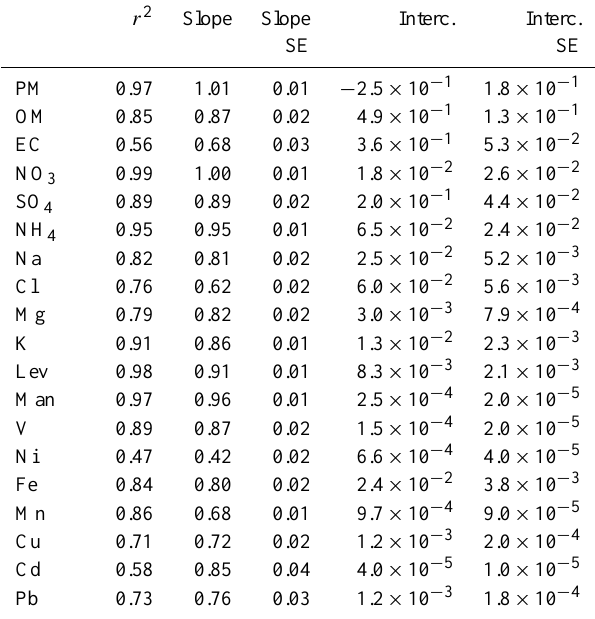
Table 1. Statistics describing measured versus modelled concentra- tions for each chemical species and for PM 2 . 5 mass. Interc.: inter- cept (µgm − 3 ), SE: standard error. r 2 Slope Slope Interc. Interc.